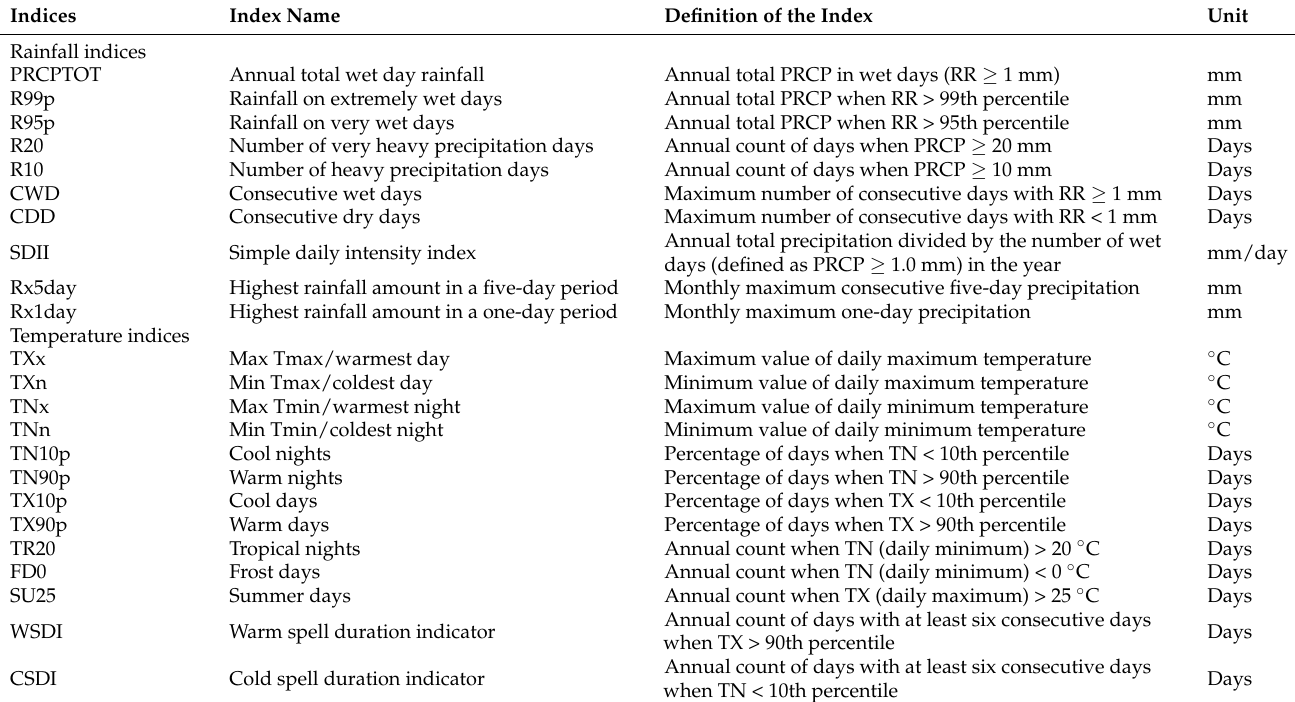
Table 2. The selected rainfall and temperature extreme indices for the